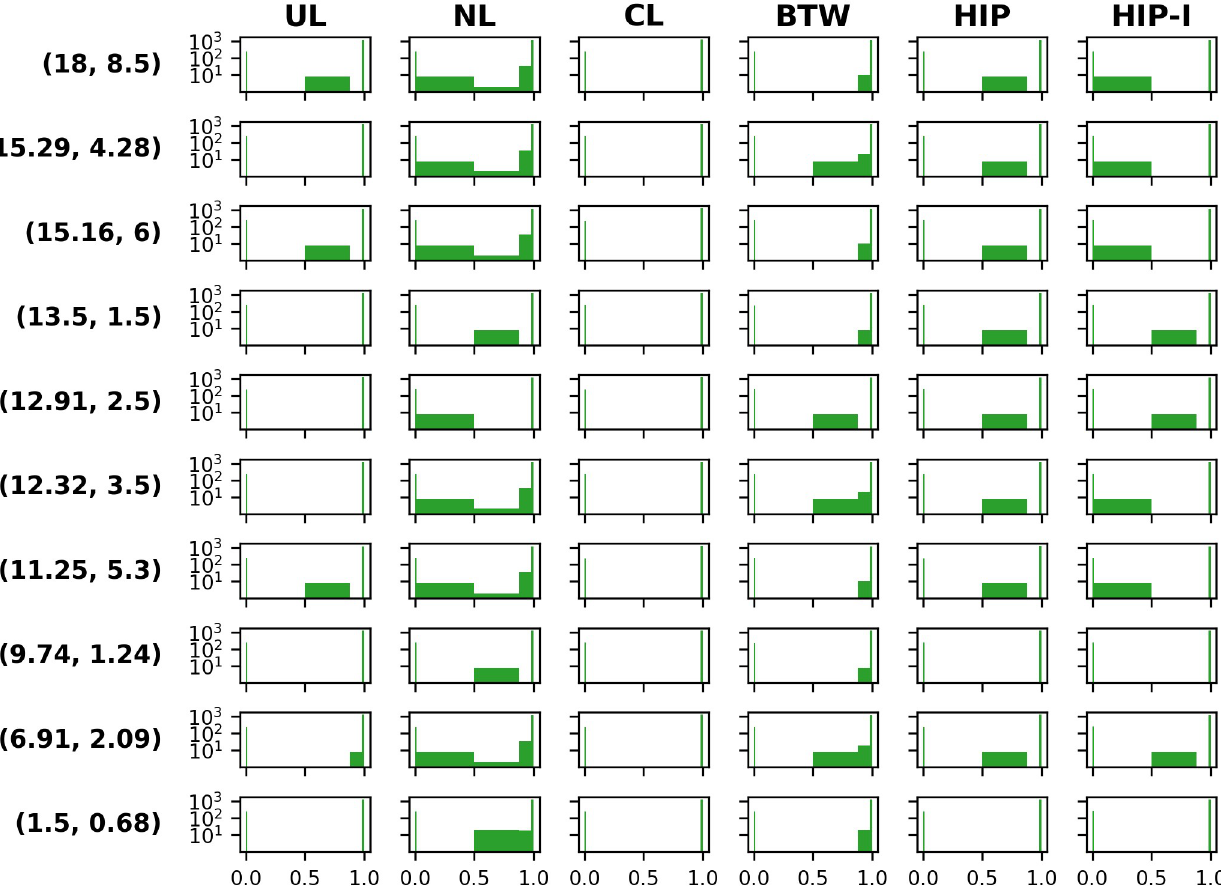
Fig 5. Single gene knockouts at 10 different environments using FBA with the biomass functions being UL, NL, or CL, and for the methods BTW, HIP and HIP-I. The environments are defined by their carbon and nitrogen uptake fluxes, where the flux value represents the maximum uptake limit. The genes are sorted according to mutant growth rate relative to the wild type, sorted into the following intervals: [0, 0.01) / [0.01, 0.50] / (0.50, 0.88] / (0.88, 0.98] / (0.98, 1]. These intervals are reflected in the width of each bar in the histograms, while the heights are the log base 2 of the number of genes falling within the respective interval. We define an essential gene as reducing the growth rate by 99% or more, hence they are represented in the first interval of [0, 0.01).